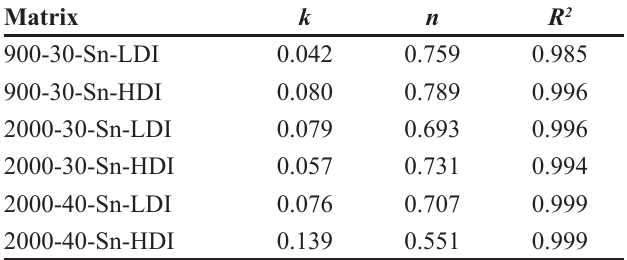
FIGURE 1 - Drug release (dissolution efficiency) curves from tablets of polyurethanes with 1% (w/w) hydrocortisone in phosphate buffer at pH 7.4 and 37 °C.